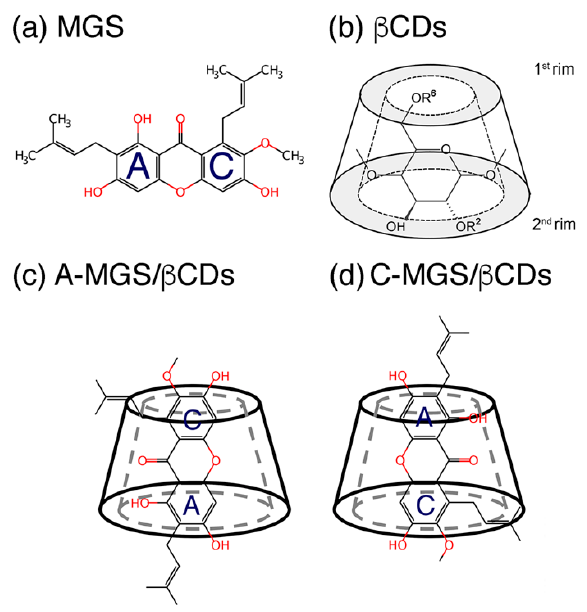
Figure 1. Chemical structure of ( a ) MGS, and schemes of ( b ) β CD and DM β CD used in this study, where R represents the hydrogen atoms for β CD and the methyl groups for DM β CD, as well as two orientations of MGS inside the β CD cavity referred to as the ( c ) A ‐ form and ( d ) C ‐ form.